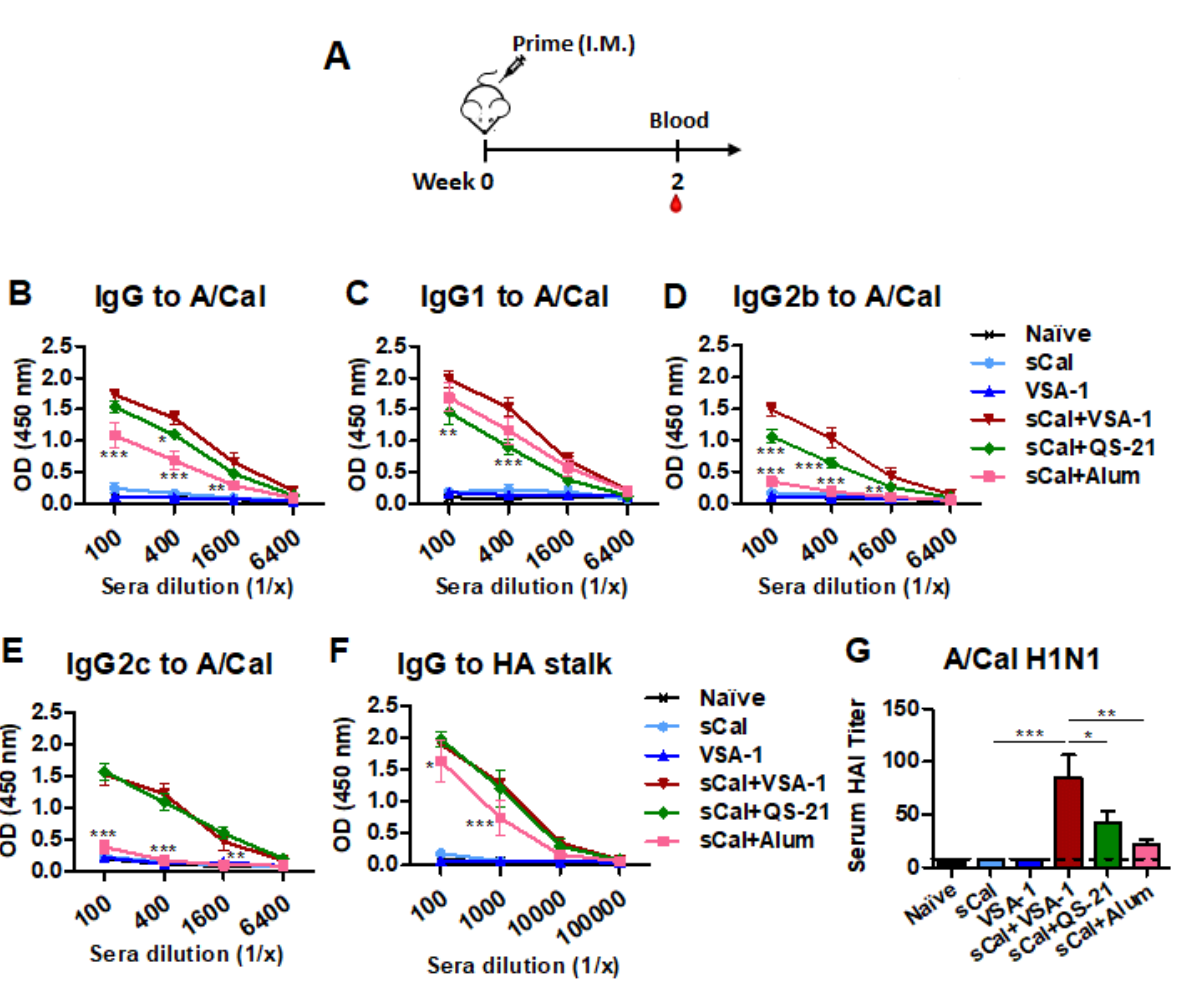
Figure 2. Prime immunization with VSA-1-adjuvanted split (sCal) vaccine enhances virus-specific IgG antibodies and HAI titers in C57BL/6 mice. ( A ) Immunization scheme ( n = 5 per group). VSA-1: Mock (no vaccine) VSA-1 control, Naïve: PBS control. ( B – E ) A/Cal H1N1 virus-specific IgG and isotype antibody levels in prime sera. ( F ) IgG specific for consensus group I HA stalk. ( G ) HAI titers against A/Cal H1N1 virus. The dotted line represents the limit of detection. Error bars indicate the mean ± standard errors of the mean (SEM). *; p < 0.05, **; p < 0.01, ***; p < 0.001 compared to the sCal + VSA-1